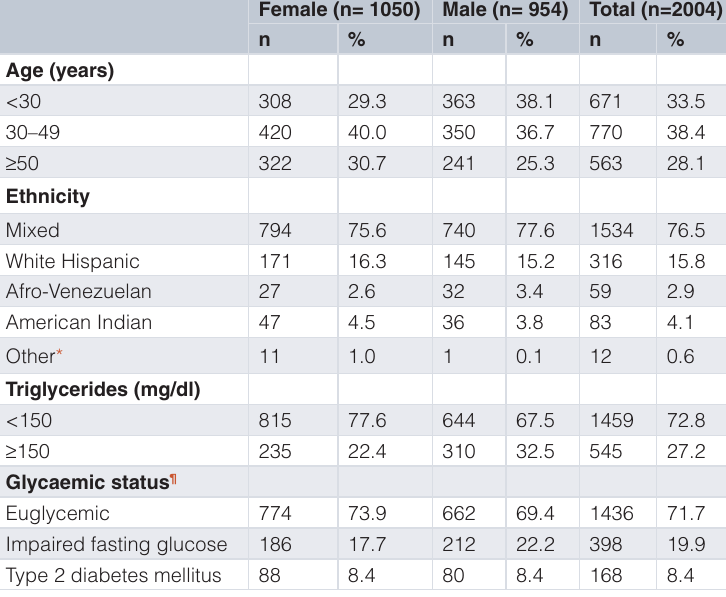
Cutoff points for the TGI in the reference population by age When assessing the predictive capacity of the TGI according to age, a higher AUC was obtained in individuals between the ages of 30 and 50 years old (AUC=0.876; 95% CI: 0.812-0.939); how- ever, when comparing AUCs among age groups, no significant differences were found. The cutoff points obtained according to age are shown in Table 5, with means similar to that proposed for the reference population (<30 years: 4.48 [65.0% sensitivity, and 84.8% specificity]; 30–50 years: 4.51 [84.7% sensitivity, and 78.3% specificity], ≥ 50 years, 4.51 [86.5% sensitivity, and 66.7% specificity]).